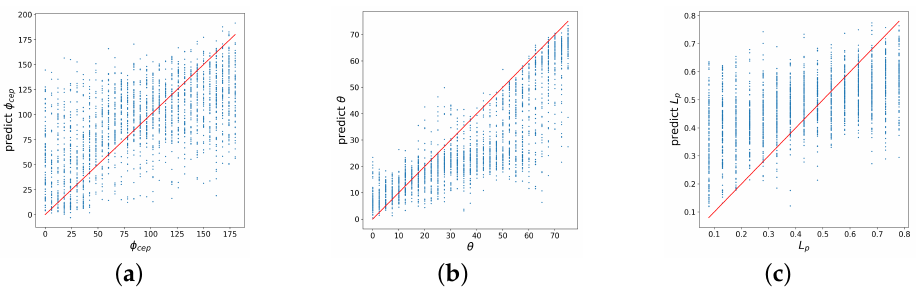
Figure 7. Correlation of the exact and predicted values of laser–plasma interaction parameters, reconstructed by a baseline fully connected NN trained on clean data and tested on noisy data: ( a ) carrier envelope phase, ( b ) incidence angle, ( c ) pre-plasma length.